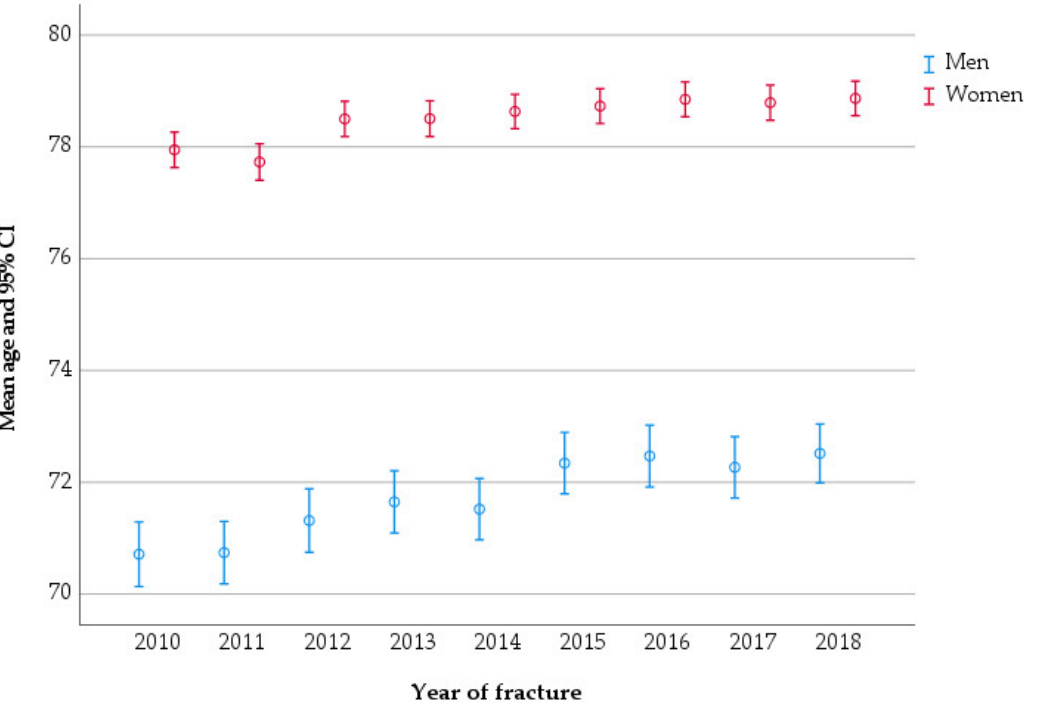
Table 1. Characteristics of patients with pelvic fracture and fracture-free controls. Pelvic Frac- ture